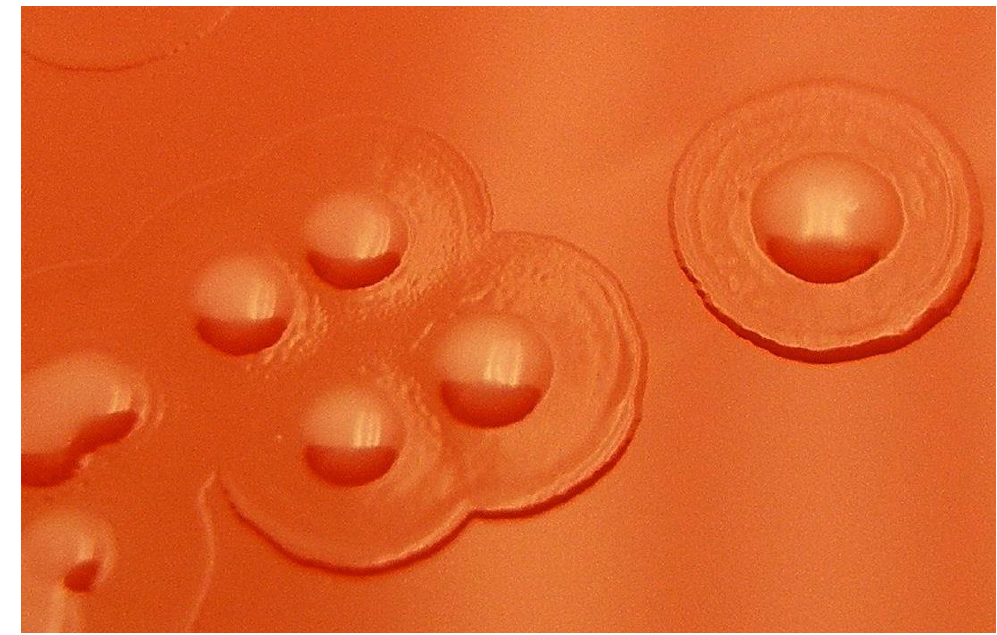
Figure 2. Fried egg appearance of Moraxella growing on trypticase soy agar supplemented with 5% sheep blood. The colonies were magnified by 20×.